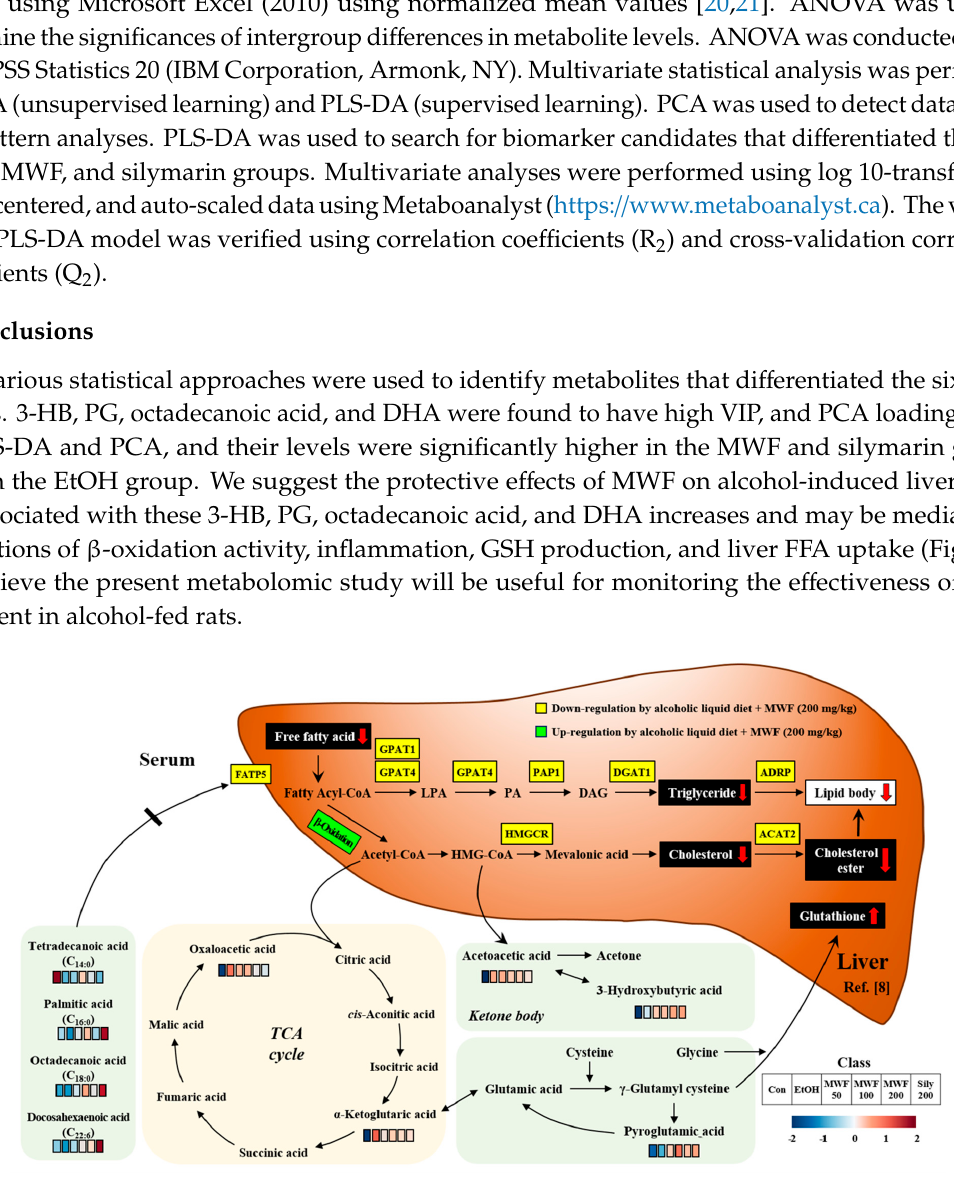
Figure 5. Predicted association indicating key findings of MWF from serum metabolic profiling and hepatic molecular mechanism in chronic alcohol-fed rats [8]. The red bars indicate an increased level of metabolite compared to the Con group. The blue bars indicate a reduced level of metabolite compared to the Con group. The white bars indicate no significant di ff erences of metabolite between the treated-group and the Con group. Levels of altered metabolites showed in Table 1 and Supplementary Table